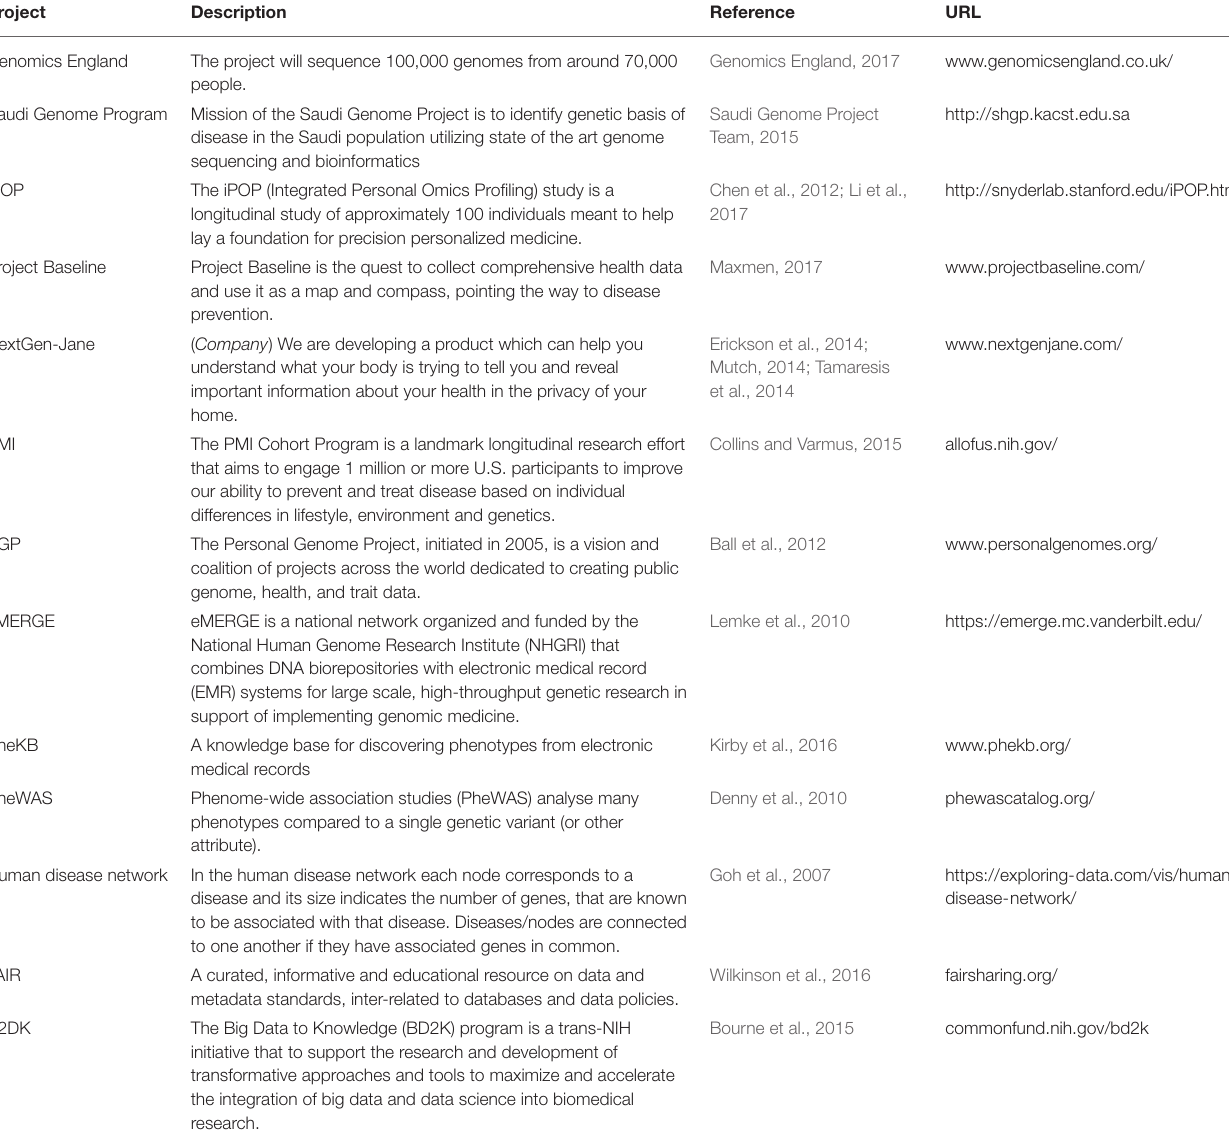
TABLE 1 | Project and